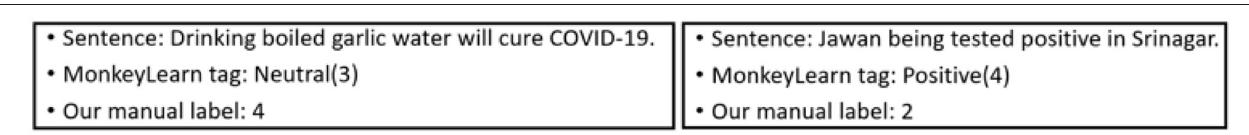
FIGURE 5 | Examples of sentiment comparison between our manual labels and machine-generated labels.